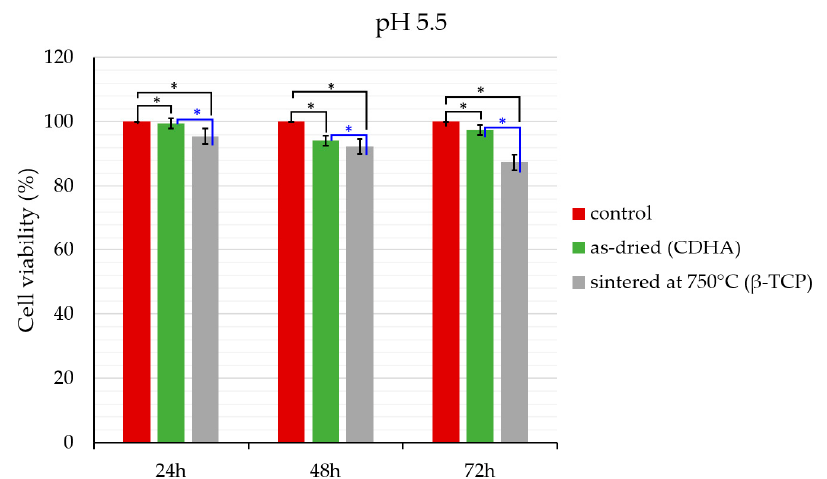
Figure 9. The effect of β -TCP particles (100 µ g/mL) on cell viability of MG-63 osteoblast-like cells. The cells treated with only cell culture media (Dulbecco’s modified eagle medium) served as a control. The results represent the mean ( ± standard deviation) of four independent experiments. One-way ANOVA analysis was performed to confirm the statistical significance between the control and the other samples at the relevant time points while the significant difference between CDHA and β -TCP was statistically analyzed by Student’s t -test ( p < 0.05).